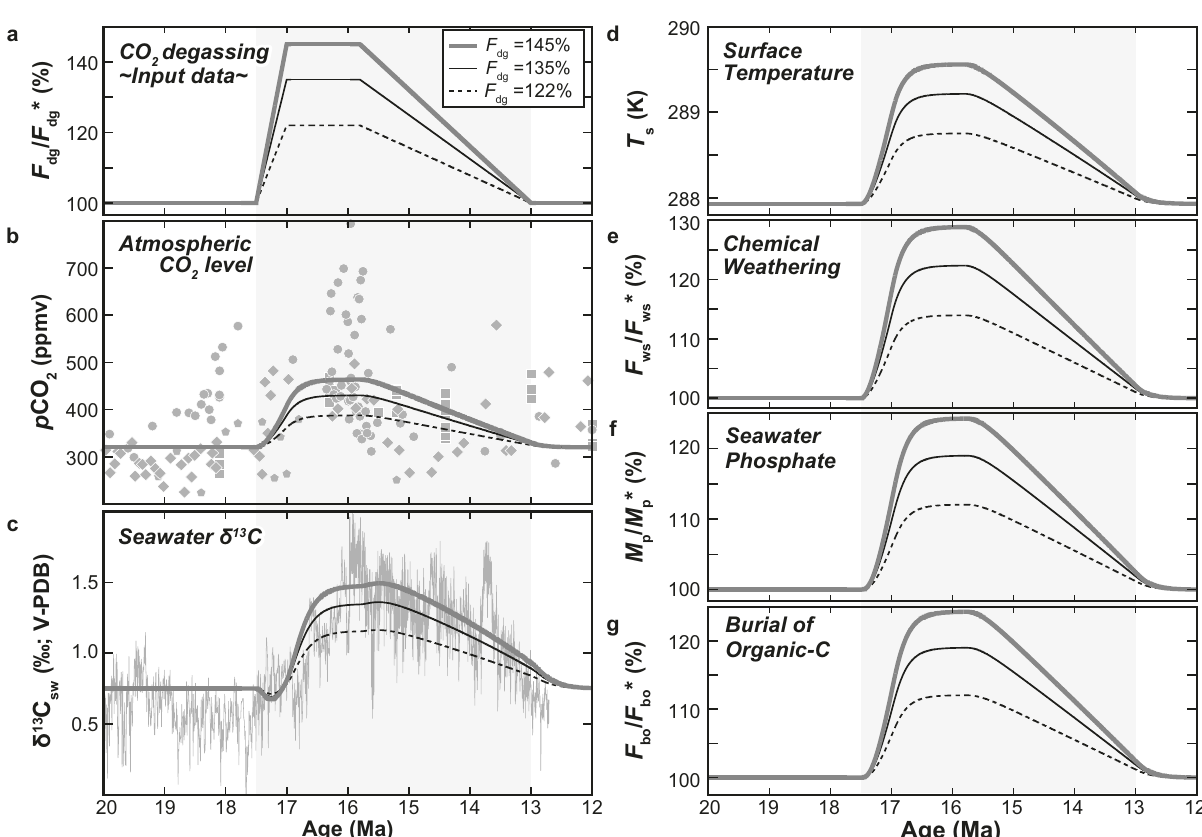
Fig. 2 The results of carbon cycle modeling. a Changes in CO 2 degassing rate ( F dg = F vc + F mc ), ( b ) atmospheric p CO 2 , ( c ) seawater δ 13 C, ( d ) mean surface temperature ( T s ), ( e ) carbon fl ux via continental weathering ( F ws ), ( f ) seawater phosphate inventory ( M p ), and ( g ) burial rates of organic carbon ( F bo ). The shaded area shows the interval of enhanced magmatism. p CO 2 and δ 13 C from Fig. 1 are also plotted in ( b ) and ( c ). Fluxes shown in ( a ), ( e ), ( f ), and ( g ) are normalized to pre-perturbation values (i.e., F dg * , F ws * , M p * , and F bo * ,